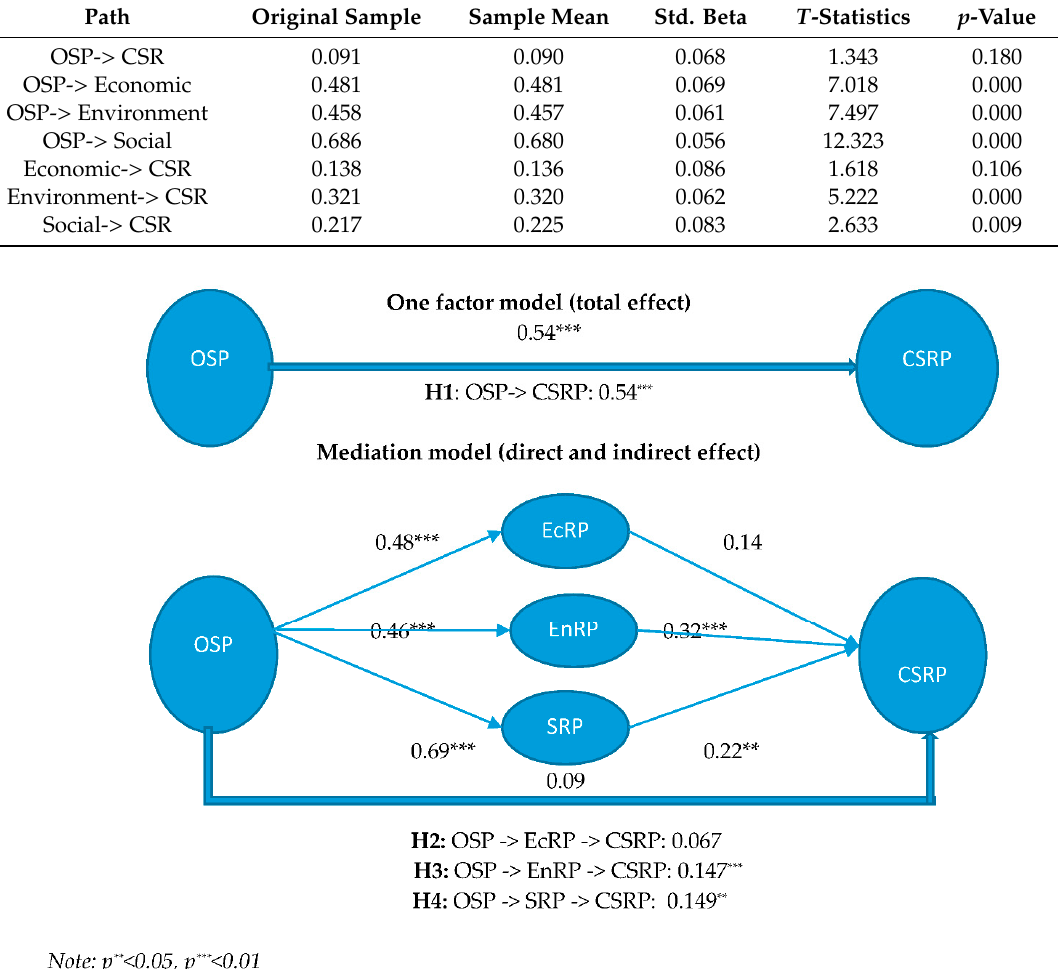
Figure 2. Research model and hypothesis testing.